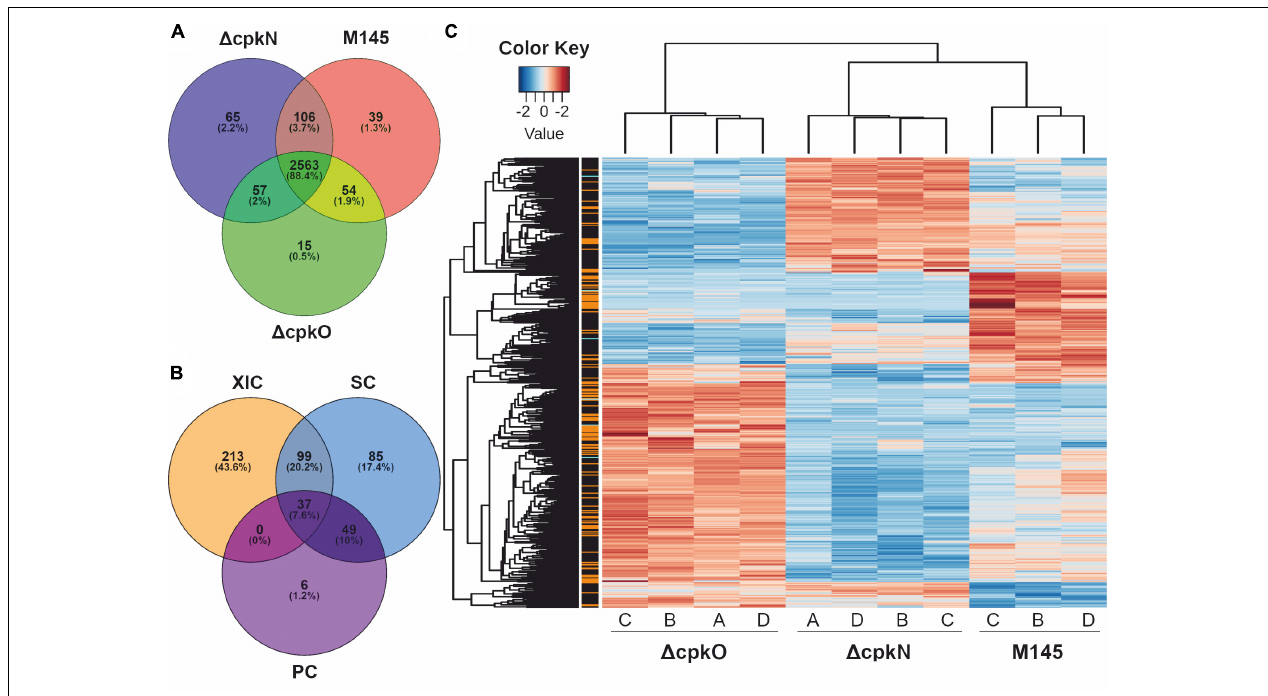
FIGURE 2 | Proteomic analysis of S. coelicolor A3(2) wild-type (M145) and mutant strains. (A) Protein identifications in the analyzed strains. (B) Quantification of 489 proteins showing significant abundance change between the strains (ANOVA test, adjusted p value < 0.01); methods: XIC, extracted ion chromatograms; SC, spectral count; PC, peak count. (C) Global heatmap representation of protein abundances with significant abundance change in function of the different strains (ANOVA test, adjusted p value < 0.01). The method of quantification of each protein is indicated in colors on the left of the heatmap for extracted ion chromatogram (black), spectral count (orange) or peak count